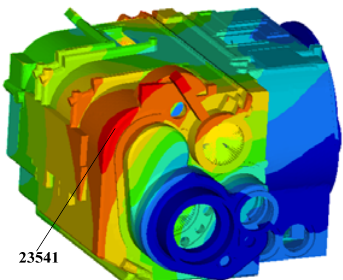
Fig.17. comprehensive strain nephogram of the gearbox housing